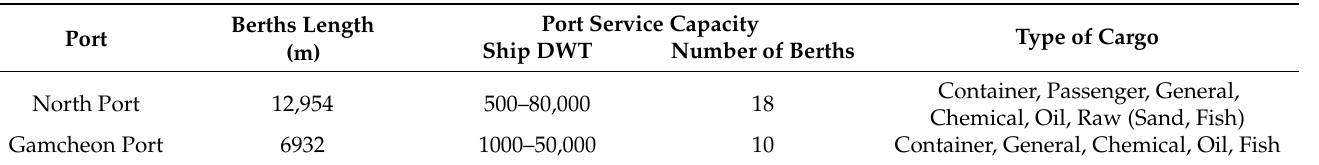
Table 2. Details of the capacity of the BP